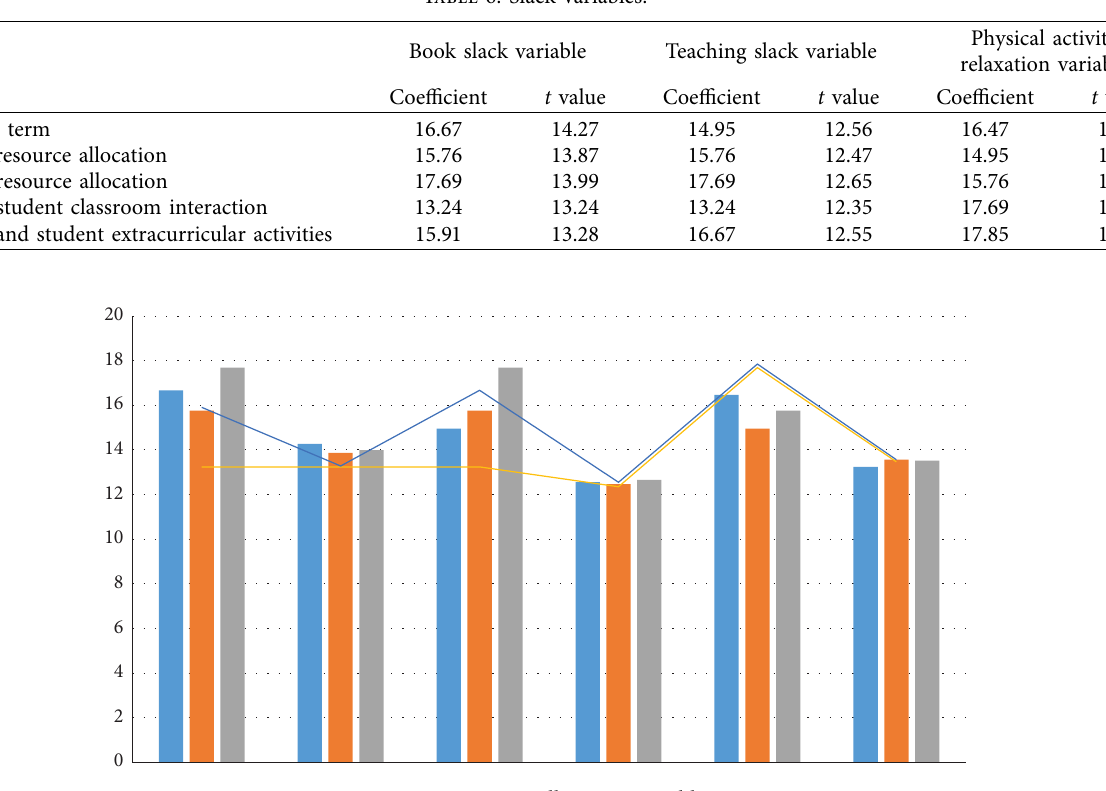
Figure 8: Resource allocation